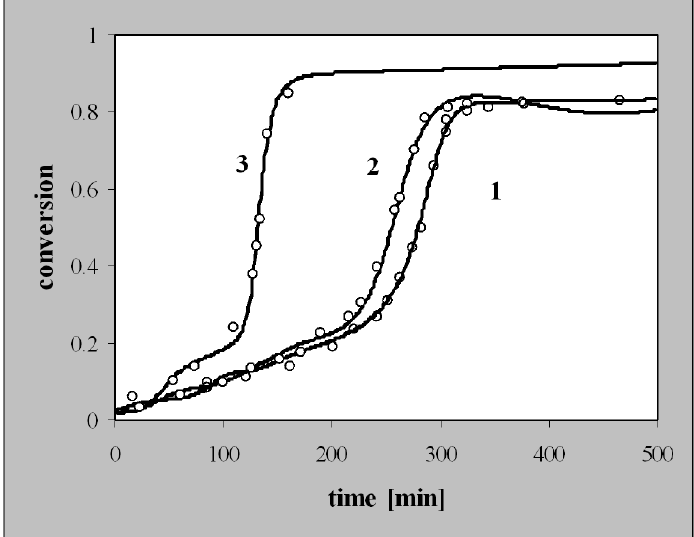
Fig. 3 Variation of monomer conversion with time for the following conditions: T = 50 o C and I 0 = 15.48 mol/m 3 ; (2) T = 50 o C and I 0 = 20.18 mol/m 3 ; (3) T = 50 o C and I 0 = 100 mol/m 3 ; o { experimental data [15],[16]; solid lines { predictions of MLP (3:9:3:1) on training data set.